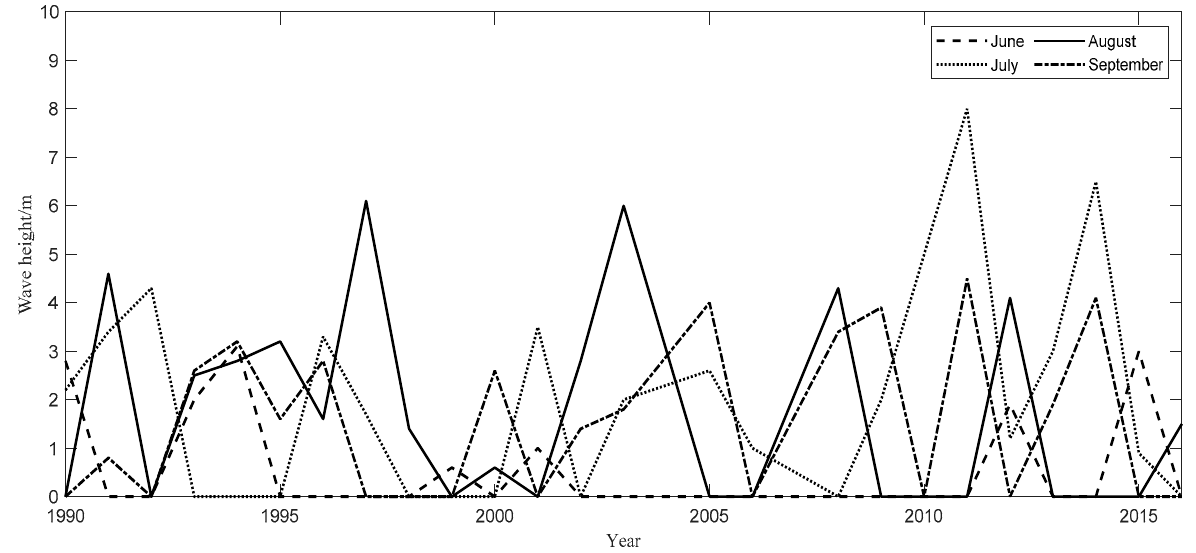
Figure 2. The wave height data scatter plot.